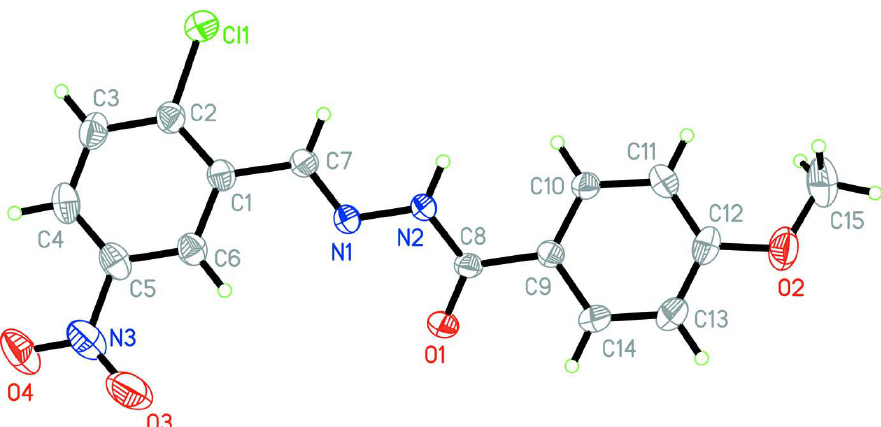
Figure 1 The molecular structure of the title compound, showing 30% probability displacement ellipsoids for the non-hydrogen atoms.